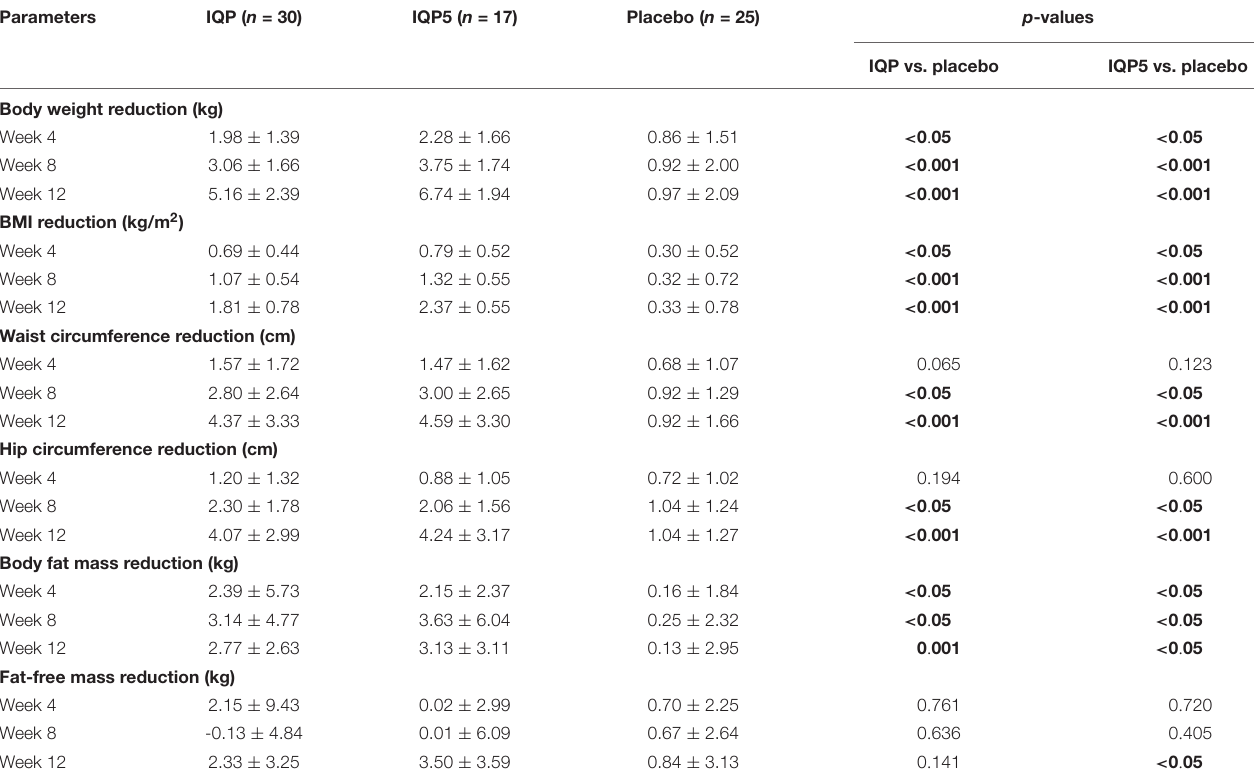
TABLE 3 | Mean reduction in body weight and other related parameters from baseline to week 4, week 8, and week 12, respectively (mean ± SD). Parameters IQP ( n = 30) Placebo ( n =